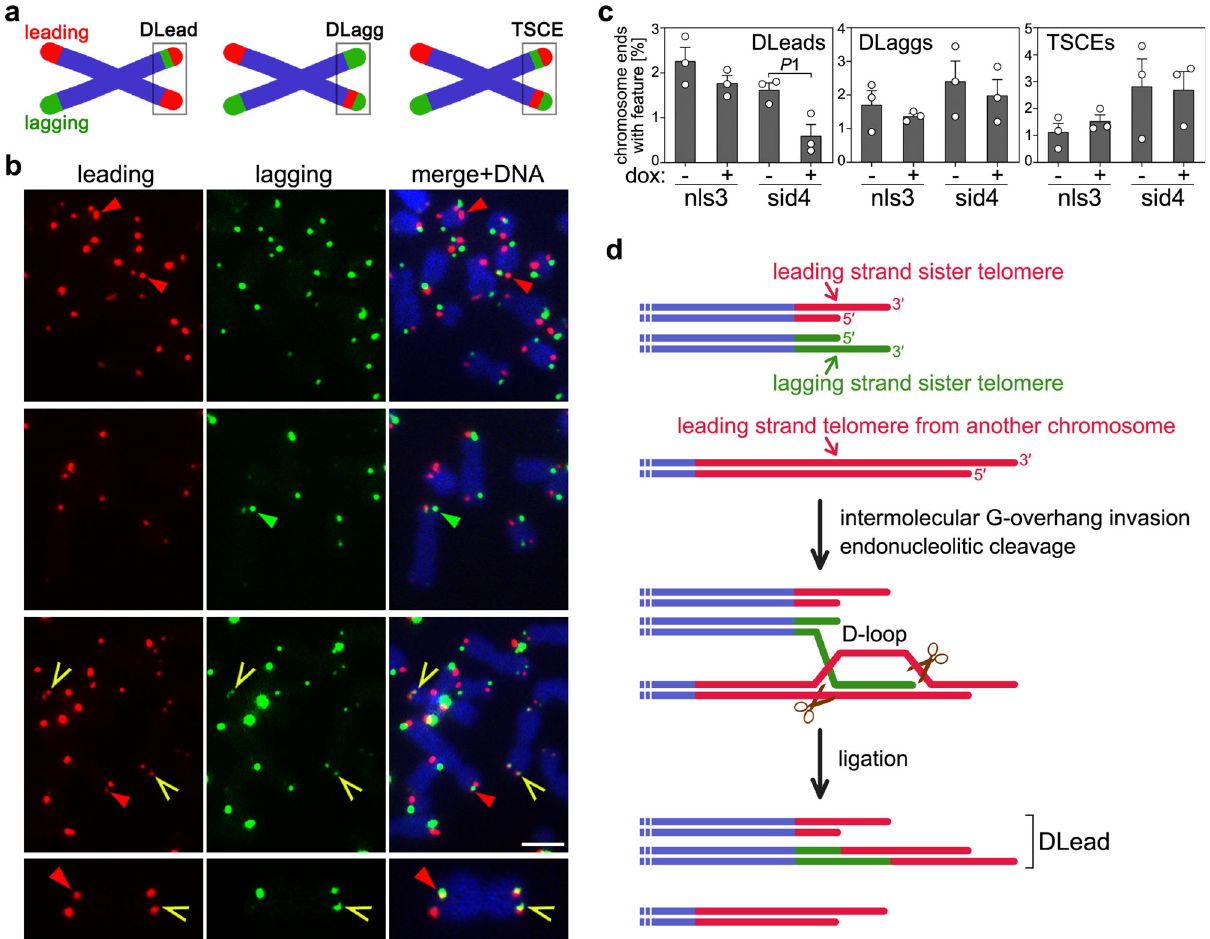
Fig. 4 TERRA transcription inhibition diminishes the frequencies of DLead chromosome ends. a Schematic representation of telomeric features scored in CO-FISH experiments. DLead: sister telomeres with 2 leading and one lagging strand signals; DLagg: sister telomeres with 2 lagging and one leading strand signals; TSCEs: telomeric sister chromatid exchanges. b Examples of CO-FISH on metaphases from sid4 cells treated with dox for 72 h. Leading and lagging strand telomeres are in red and green, respectively; DAPI-stained DNA is in blue. Red arrowheads point to DLeads, green arrowheads to DLaggs, and yellow arrows to TSCEs. Scale bar: 5 μ m. A chromosome with one DLead and one TSCE at its two opposite ends is shown at a 3-fold magni fi cation at the bottom. c Quanti fi cations of telomeric features in CO-FISH experiments as in b . A total of at least 2538 chromosomes from 3 independent experiments were analyzed for each condition. Bars and error bars are means and SEMs. Circles are single data points. P -values were calculated with a two-tailed Student ’ s t -test. P 1 = 0.0268. d Speculative model for DLead generation. Scissors represent structure-speci fi c endonucleases. See the “ Discussion ” section for details. Source data are provided as a Source Data fi